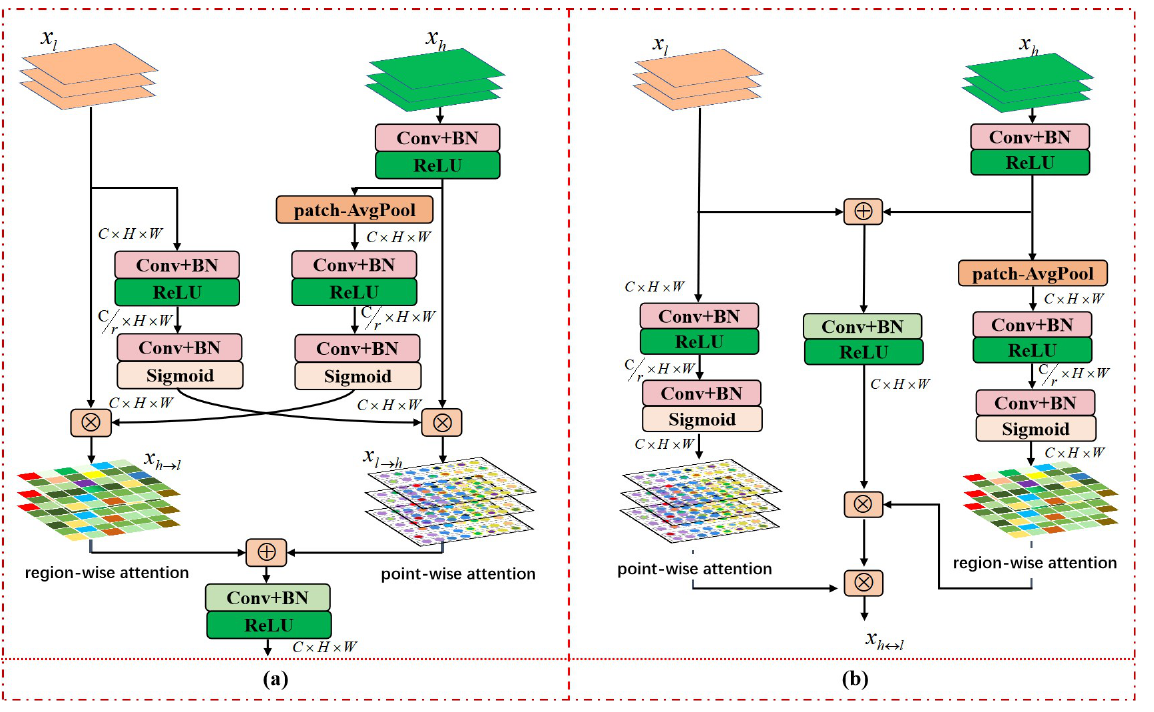
Figure 5. The illustration of the pair-wise asymmetric combination. ( a ) Parallel asymmetric combina- tion. ( b ) Hierarchical asymmetric